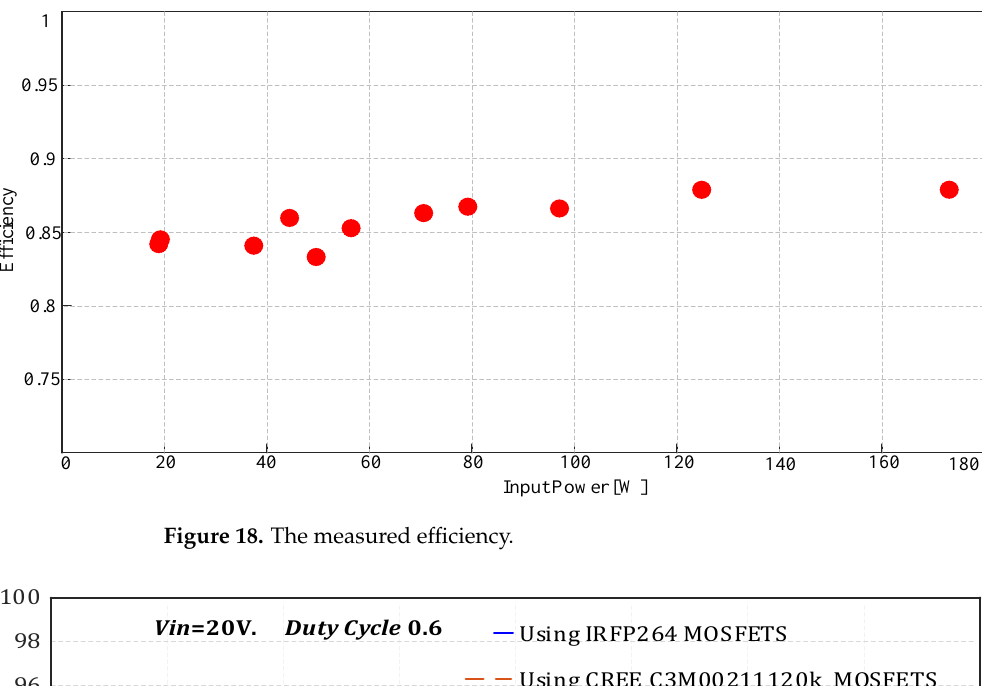
Figure 17. The ideal and measured voltage gain.